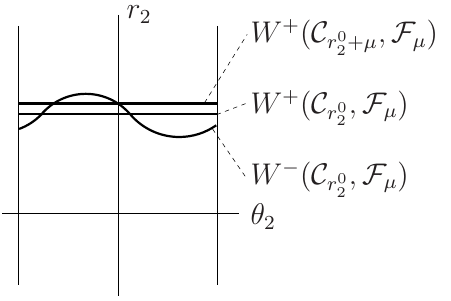
Fig. 2 Homoclinic and heteroclinic intersections in the annulus